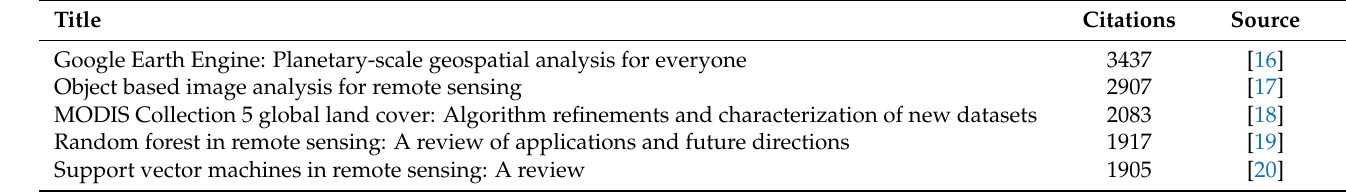
Table 1. Five most cited articles in the field of remote sensing published between 2010 and 2021 according to the Web of Science (accessed on 20 June